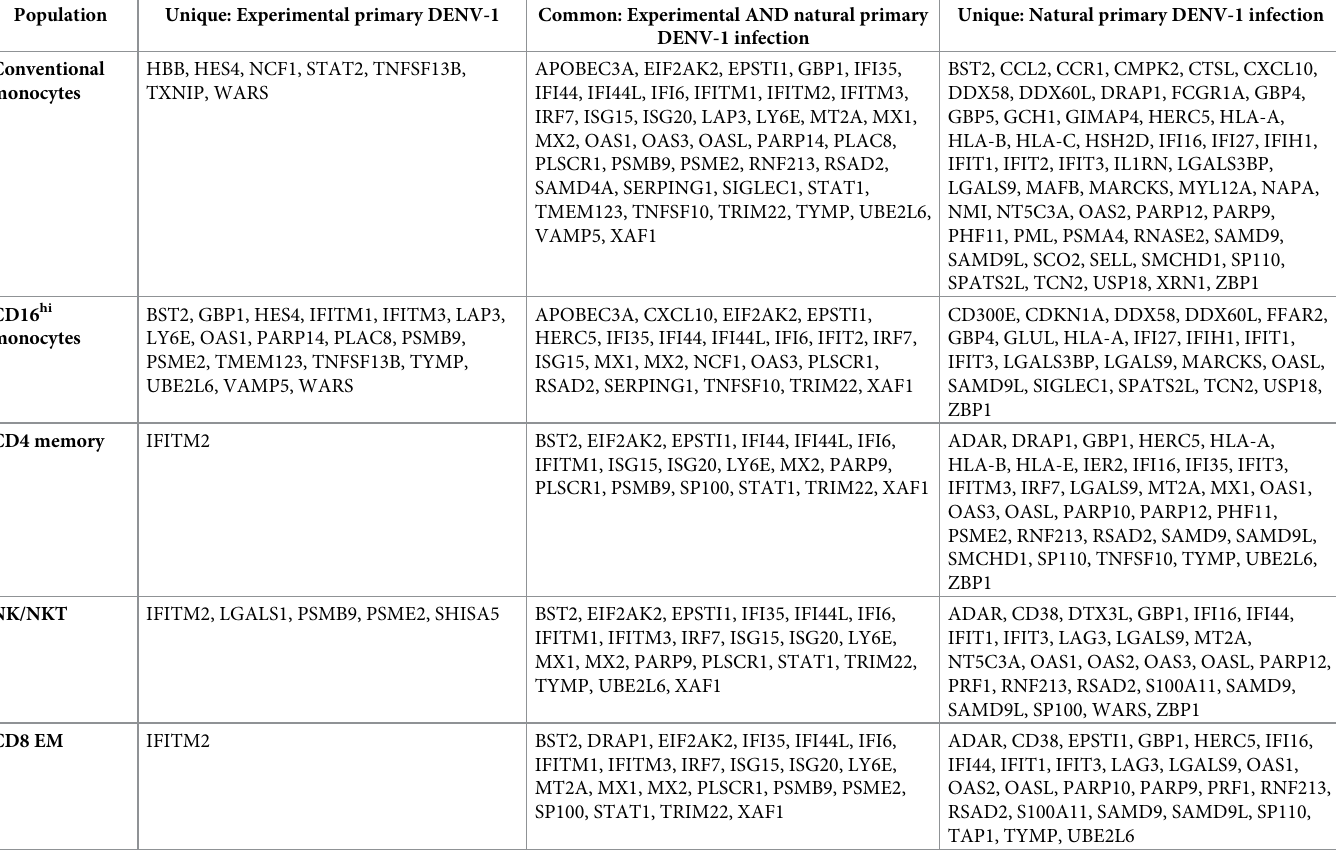
Unique: Natural primary DENV-1 infection DENV-1 infection